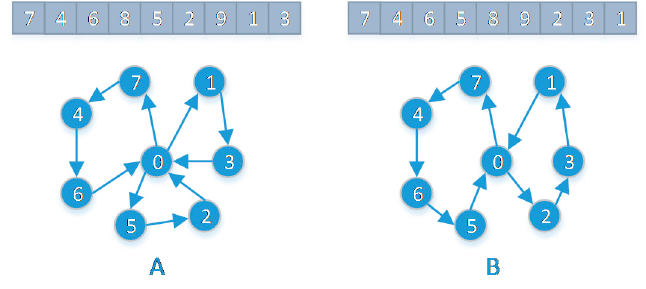
Figure 2. Butterfly representation and solution decoding.